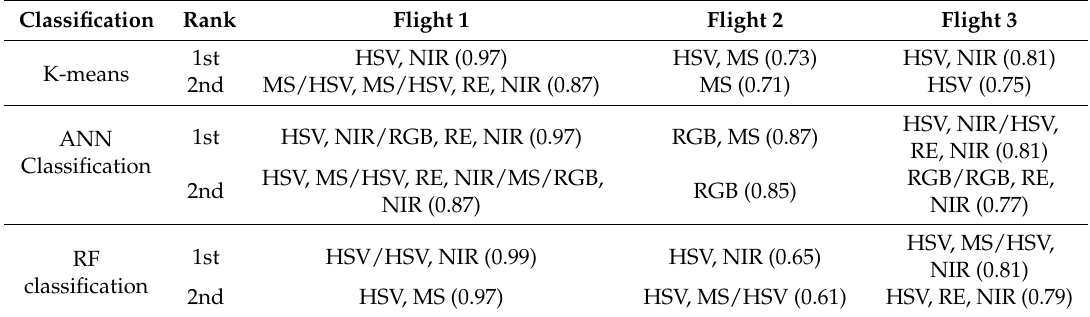
Figure 9. A comparison between measured and NIR-derived median grain size (+) using Equation (4). The line of best fit and its equation is also plotted. r 2 and p values for the correlation is given in the top left-hand corner of the graph. Table 3. First and second ranked classifications for the different flights and classification routines with values of j in brackets.